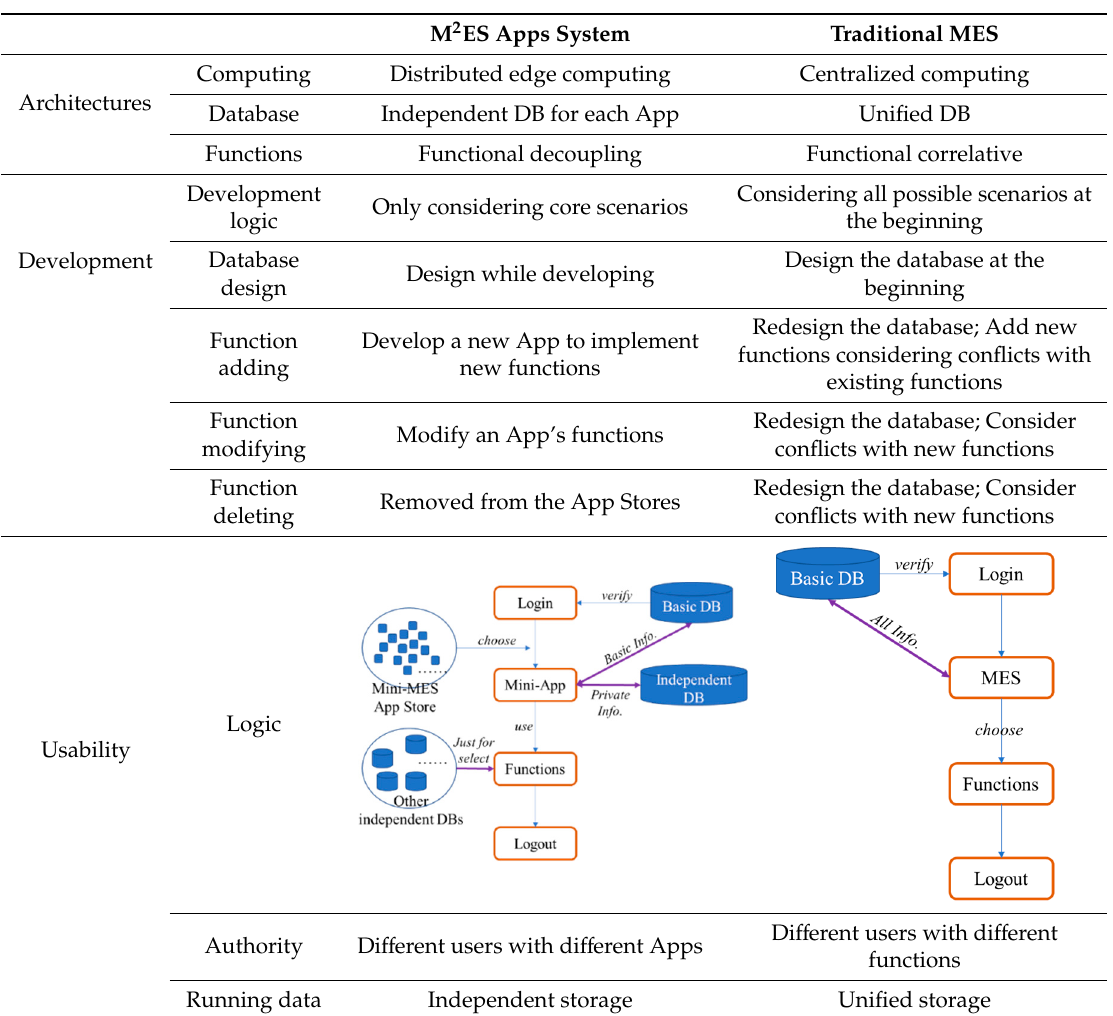
Table 1. Di ff erences between M 2 ES Apps System and Traditional MES. Table 1. Differences between M 2 ES Apps System and Traditional MES. Table 1. Differences between M 2 ES Apps System and Traditional